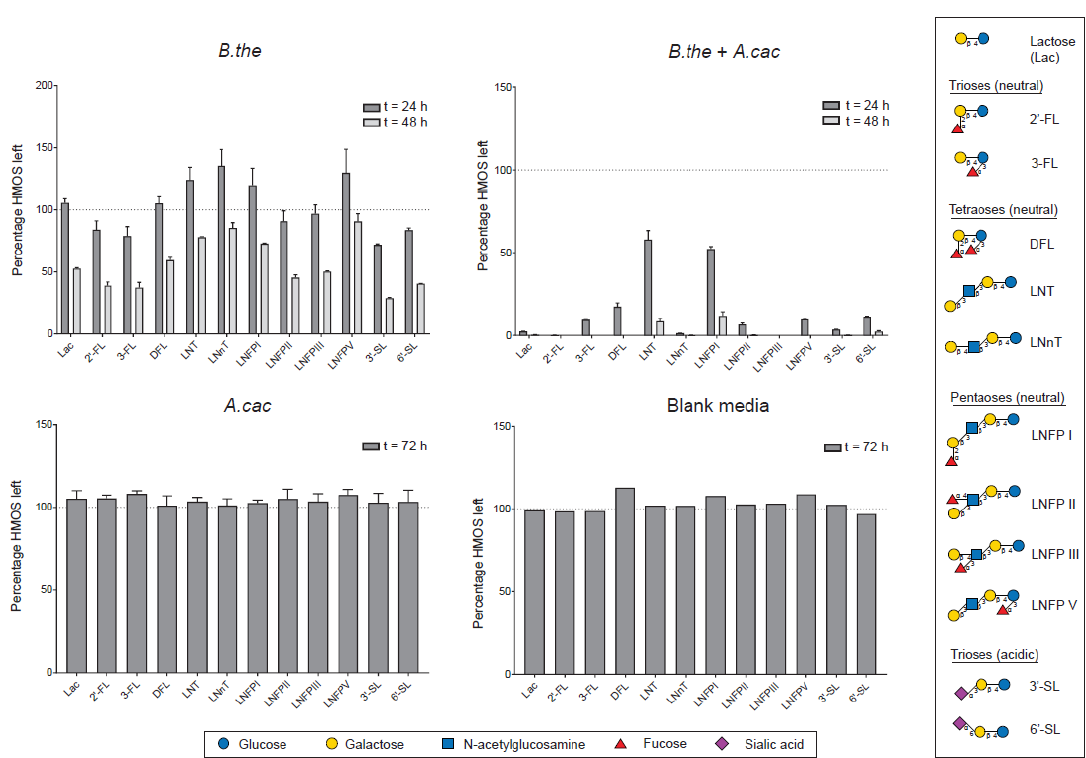
Figure 3. B. thetaiotaomicron monoculture and B. thetaiotaomicron + A. caccae co-culture showed differential utilization of human milk oligosaccharide (HMOS) structures. The percentage of HMOSs left in B. thetaiotaomicron monoculture is significantly higher ( p < 0.05) than B. thetaiotaomicron + A. caccae co-culture at 24 and 48 h for all structures. Error bars represent the error propagation for the mean of three (for A. caccae ) or four (for B. thetaiotaomicron and B. thetaiotaomicron + A. caccae ) biological replicates measured in technical triplicates. The blank control was measured only in technical triplicates. Abbreviations: 2′-FL, 2′-fucosyllactose; 3-FL, 3-fucosyllactose; DFL, difucosyllactose; LNT, lacto-N-tetraose; LNnT, lacto-N-neotetraose; LNFP I, lacto-N-fucopentaose I; LNFP II, lacto-N-